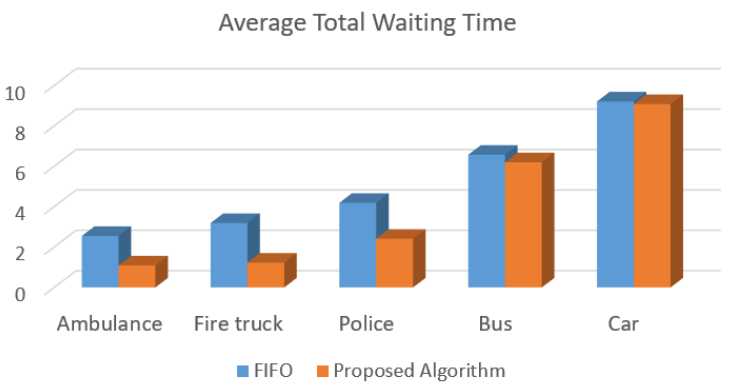
Figure 9. Average total waiting time reached by the proposed traffic control algorithm and FIFO for each type of vehicle.